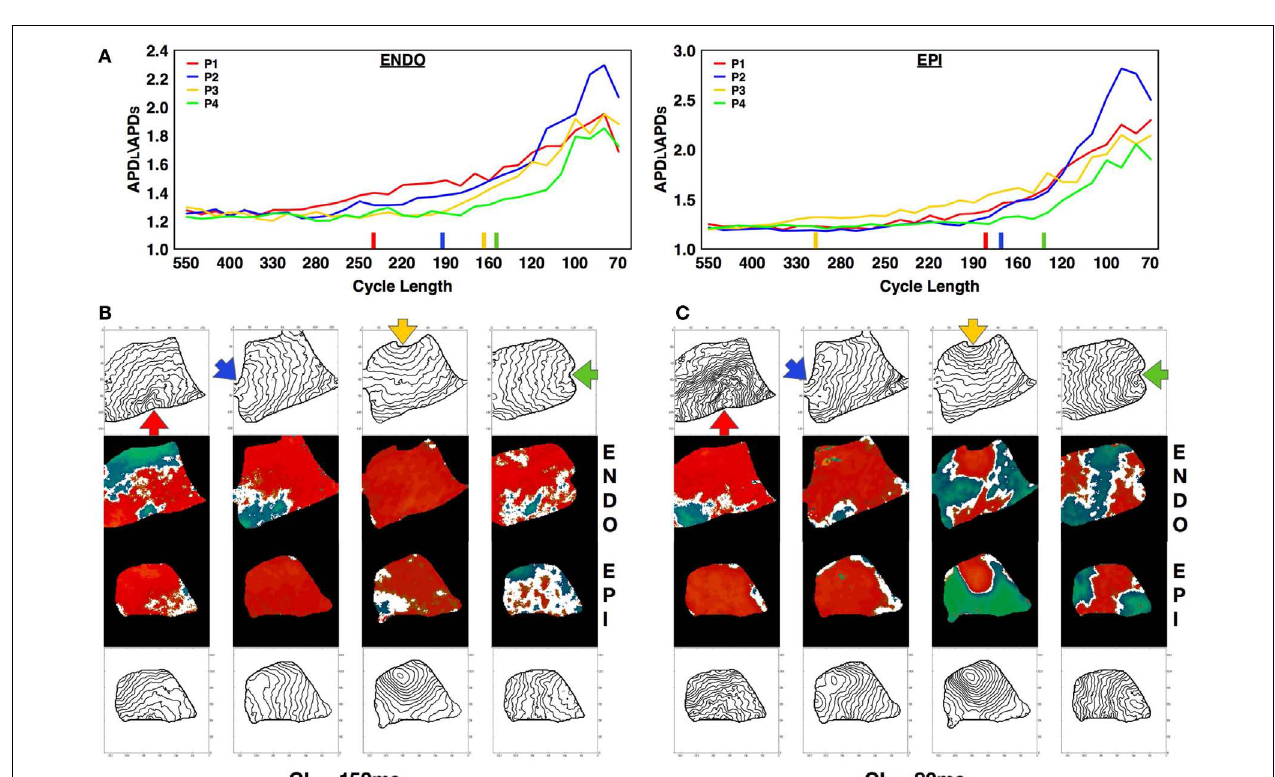
Colored bars on the x-axes indicate the points at which each curve has grown by more than 10% compared to its value at the longest CL. (B,C) Alternans maps and activation contour maps at CLs of (B) 150ms and (C) 80ms for endocardium and epicardium showing the differences obtained by pacing from the four distinct